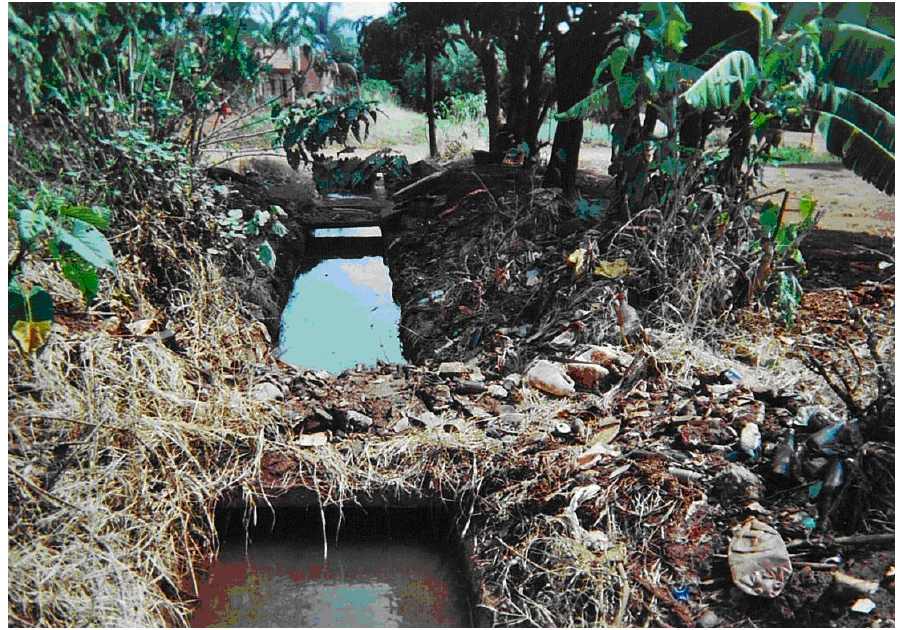
Figure 2 Reasons for compliance with scheme rules (% of